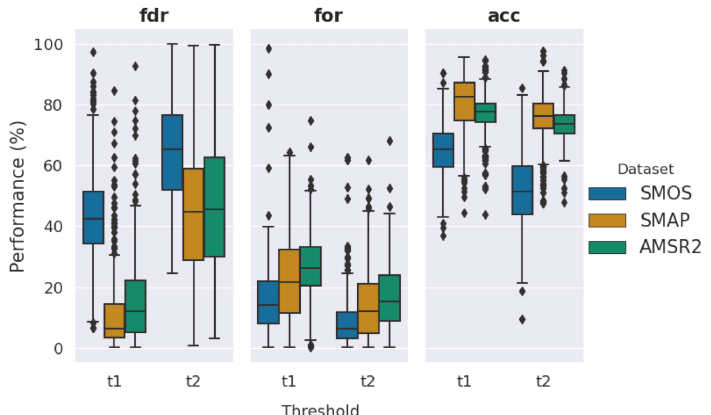
Figure 9. Boxplots of the false discovery rate (fdr), false omission rate (for) and accuracy (acc) based on 399 ground stations for threshold t1 (SWE > 50 mm and / or TS < 0) and threshold t2 (SWE > 200 mm and / or TS < − 1) for the three snow, frozen soil, and ice (SFI) flags of SMOS, SMAP, and the new method applied on AMSR2.